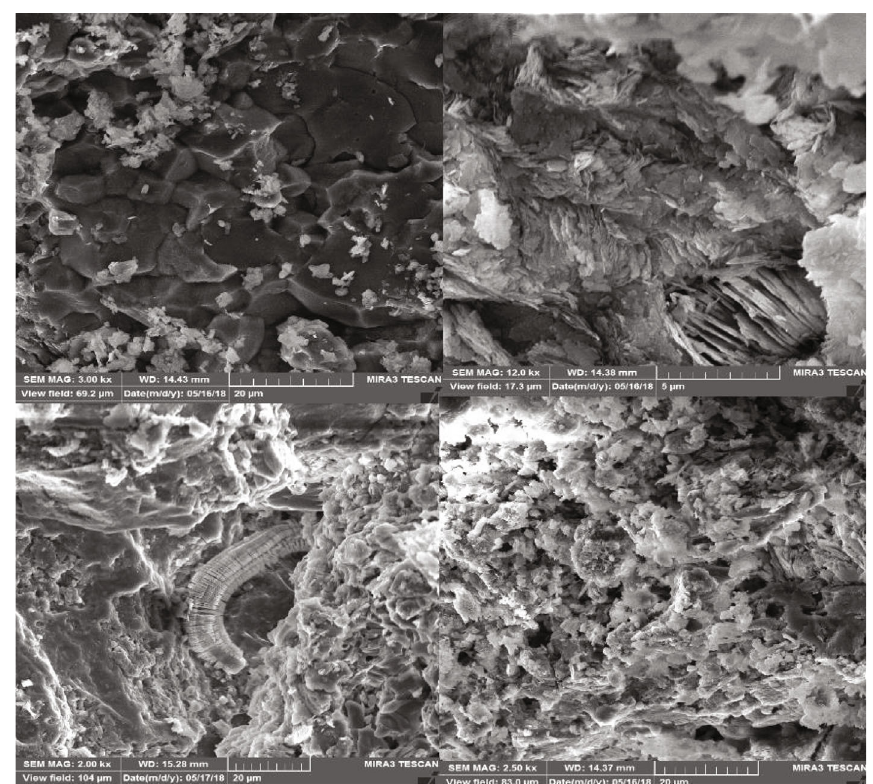
Figure 4: The framework of weakly cemented sandstones by